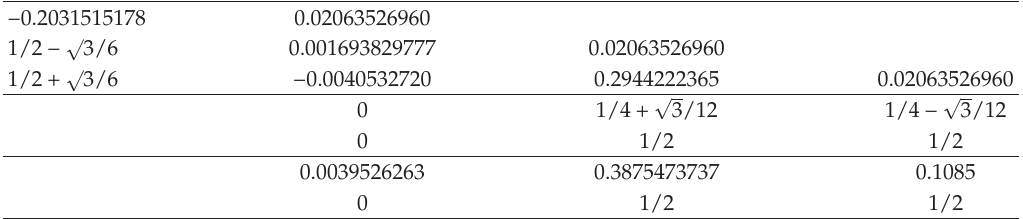
Table 2: The DIRKN4 (cid:2) 3 (cid:3) 6New method.